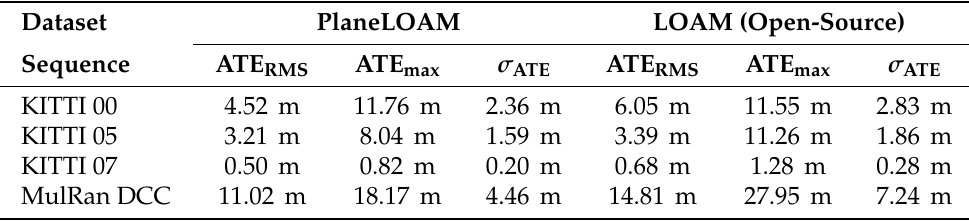
Table 1. Comparison of ATE errors for publicly available LiDAR datasets recorded in urban environments.